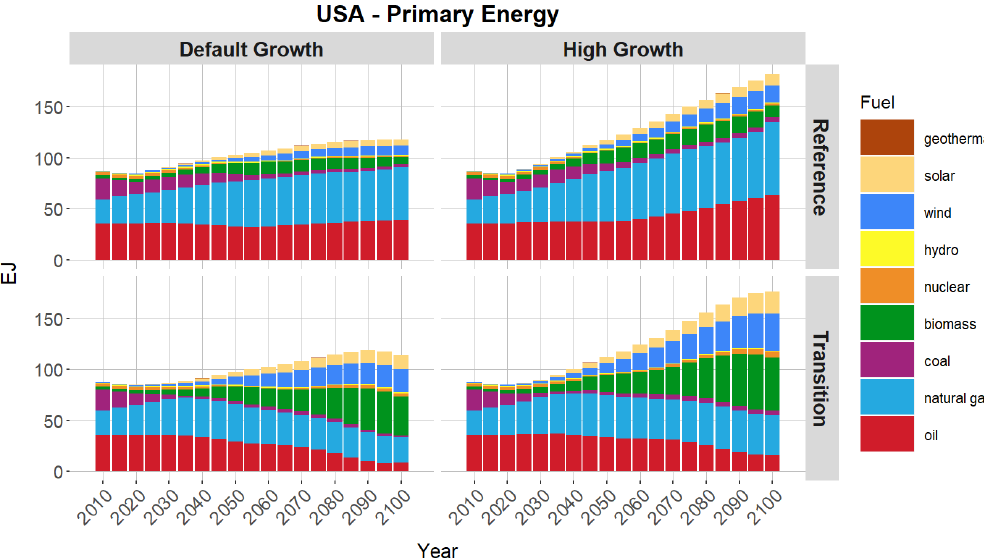
Figure 3. US primary energy consumption (national total) by fuel and scenario. Columns reflect alternate assumptions about socioeconomic drivers; rows represent alternate assumptions about energy system evolution.